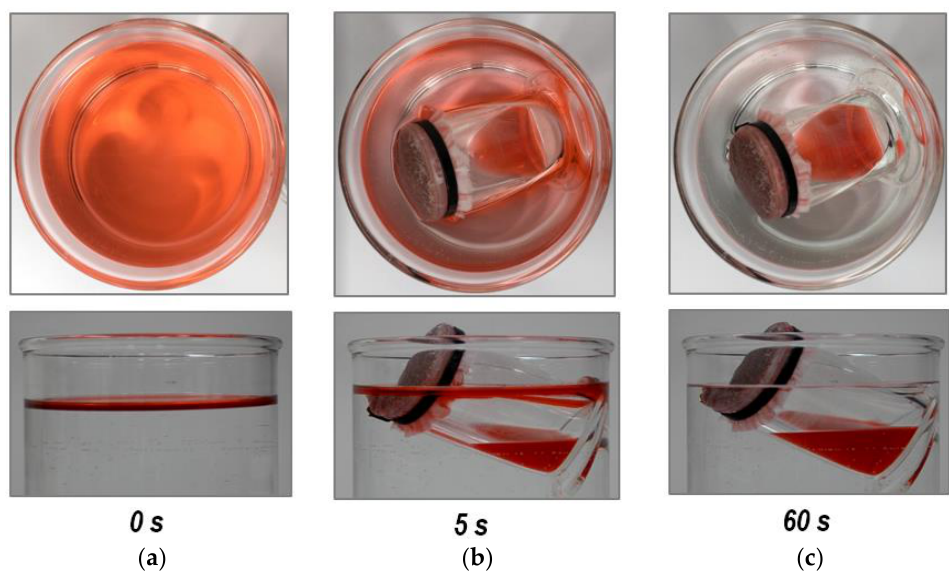
Figure 7. Snapshots of the barrel-shaped oil skimmer taken at different times of ( a ) 0 s, ( b ) 5 s, and ( c ) 60 s. They display the operation process of collecting n -hexane (dyed red) from the surface of water. The upper and bottom images correspond to top and side views, respectively.